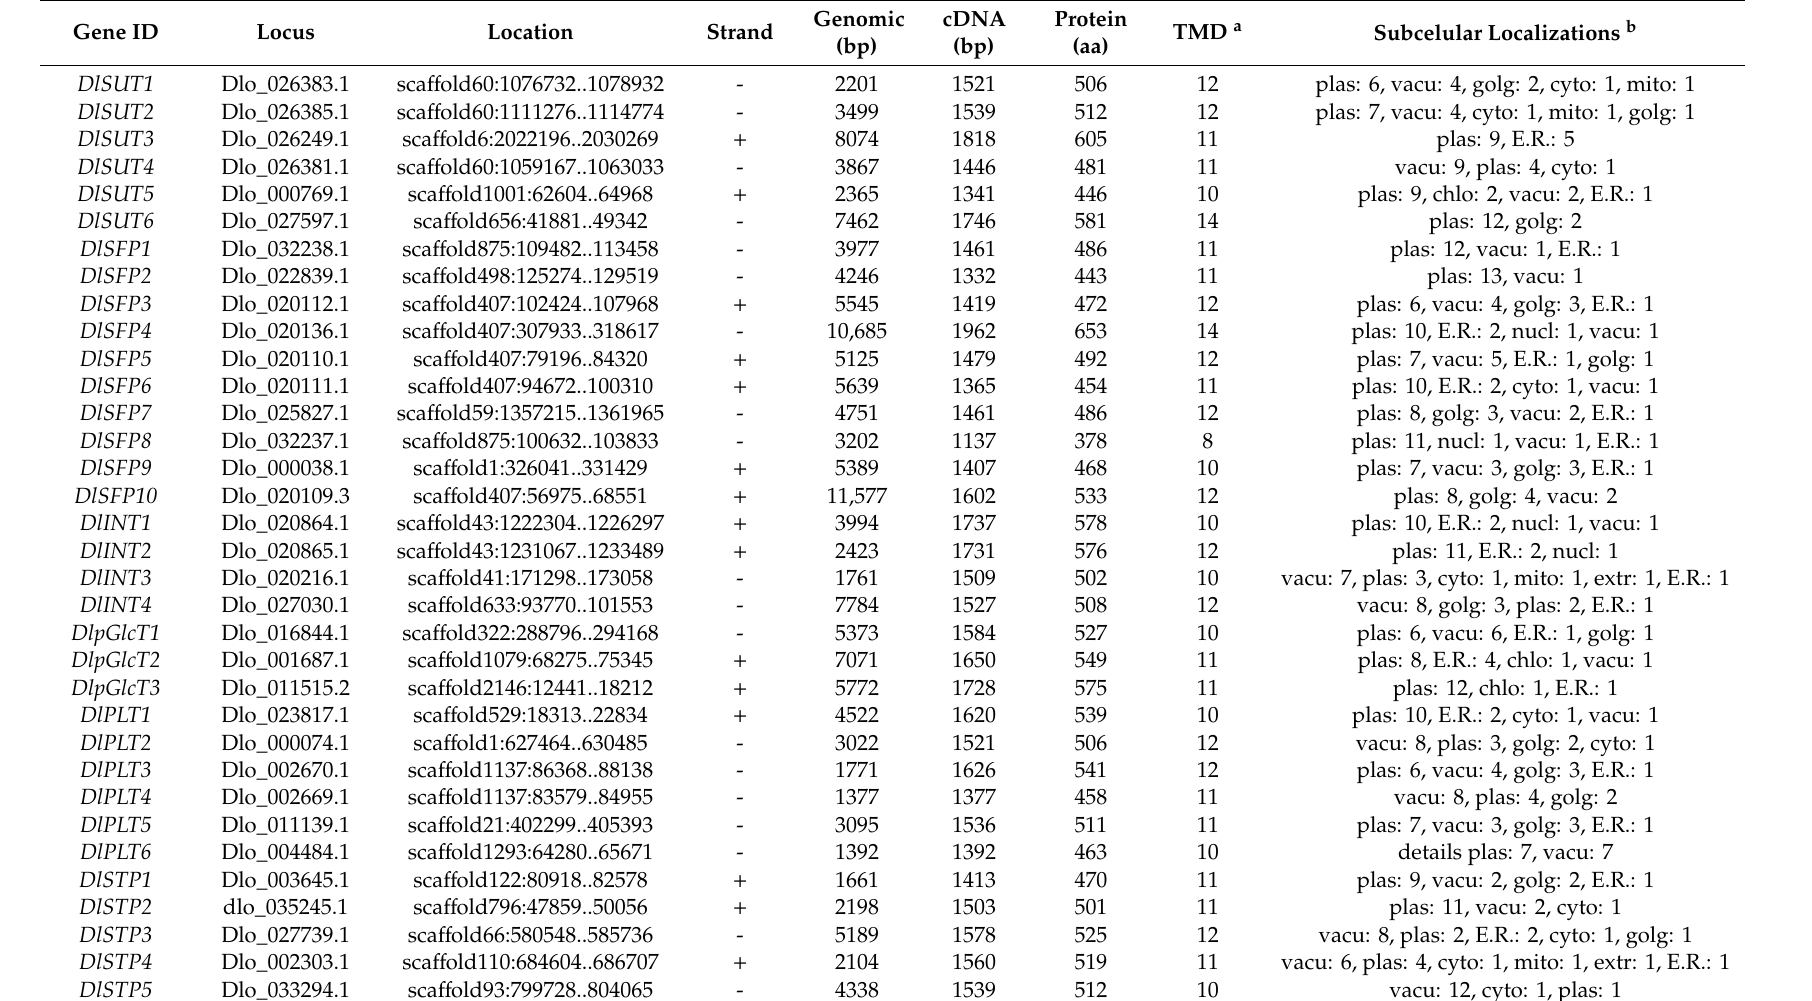
Table 1. Characteristics of 52 DlST genes in